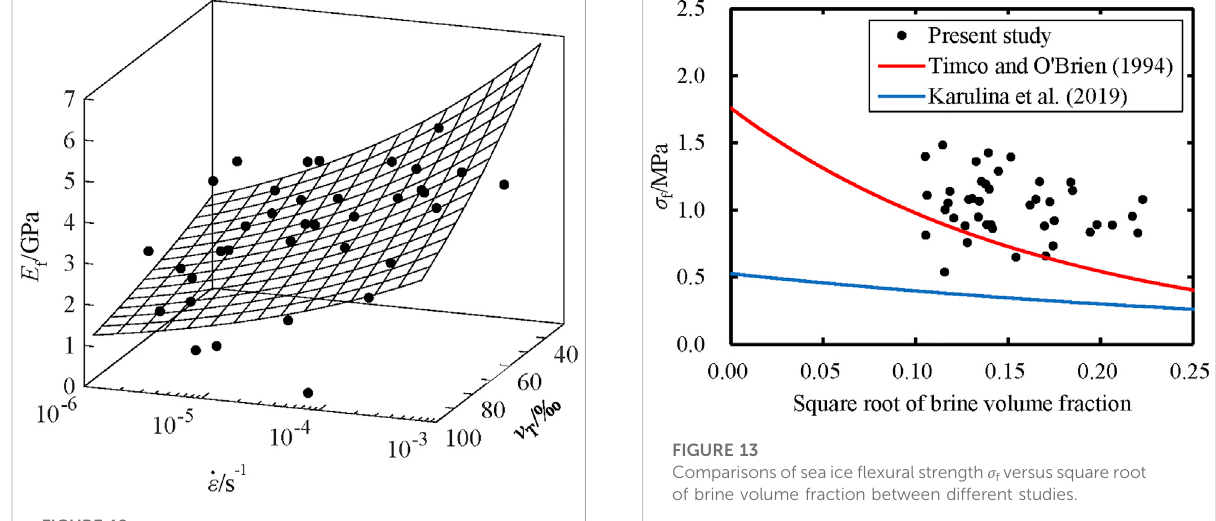
FIGURE 12 Three-dimensionalsurfaceoftheeffective elastic modulus E f regarding porosity ] T and strain rate _ ε for ice samples.